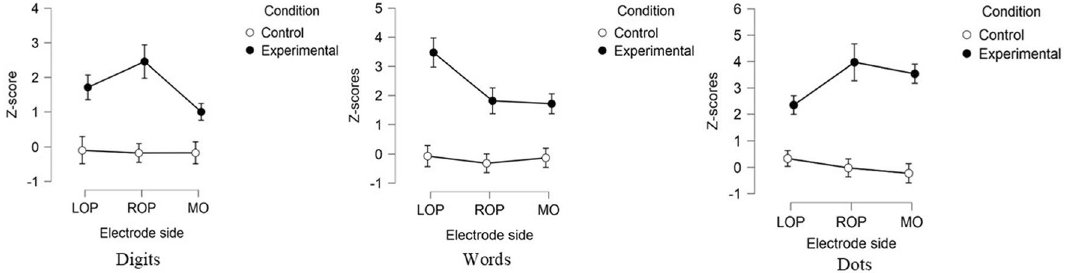
Figure 3. Z-scores for the single notation trials—digits, words, and dots, depicted as a function of the condition (control vs experimental) and electrode side. LOP = Left Occipito-Parietal, ROP = Right-Occipito Parietal, MO = Medial-Occipital.Vertical bars denote Standard Errors